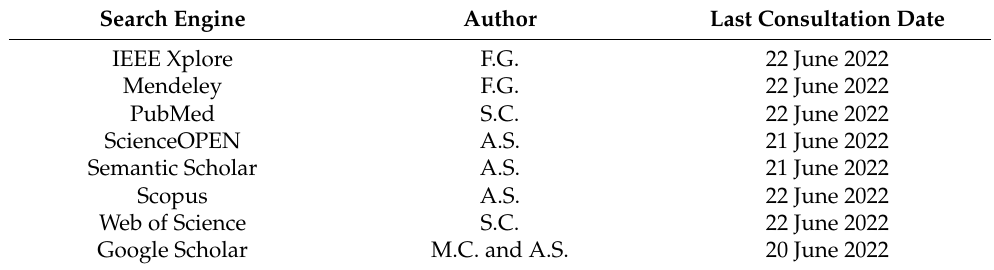
Table 1. Search engine information summary. The authors names are reported with their initials.